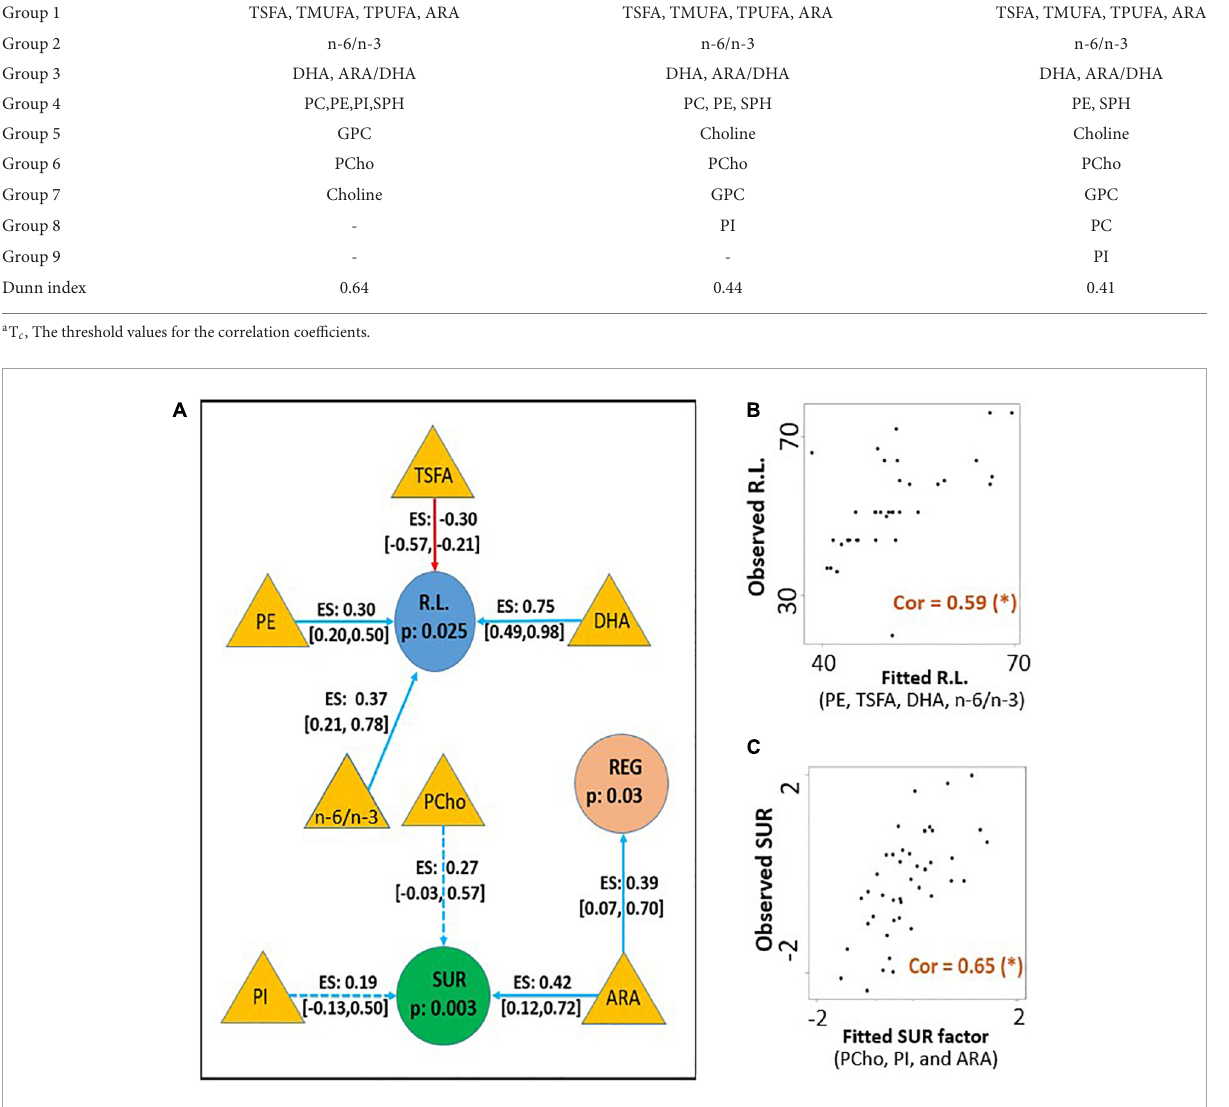
FIGURE4 (A) The identified conditional effects of human milk nutrients (filled triangles) on receptive language score (R.L., filled blue circles) and surgency (SUR, filled green circles) using linear regression. The blue and red arrows represent the positive and negative associations, respectively.